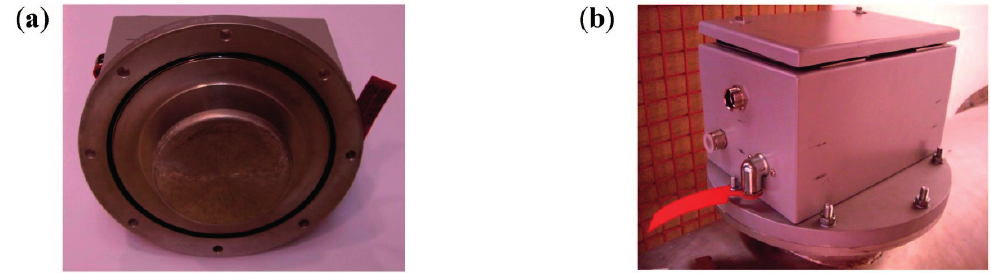
Figure 7. ( a ) Metal plate of the invasive UHF sensor; ( b ) External view of the sensor installed in a GIS compartment.